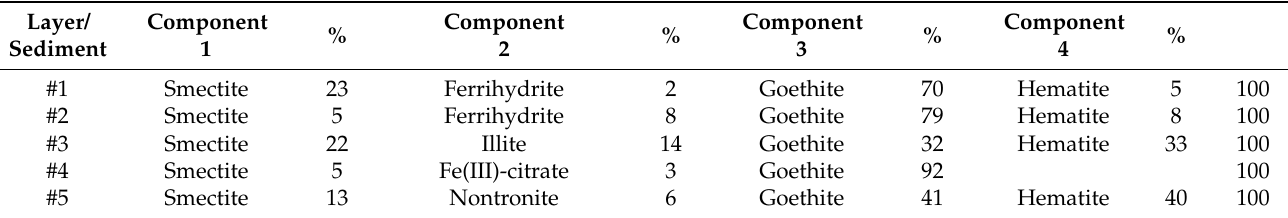
Table 2. Results for the LCF performed on the normalized Fe K-edge XANES spectra.